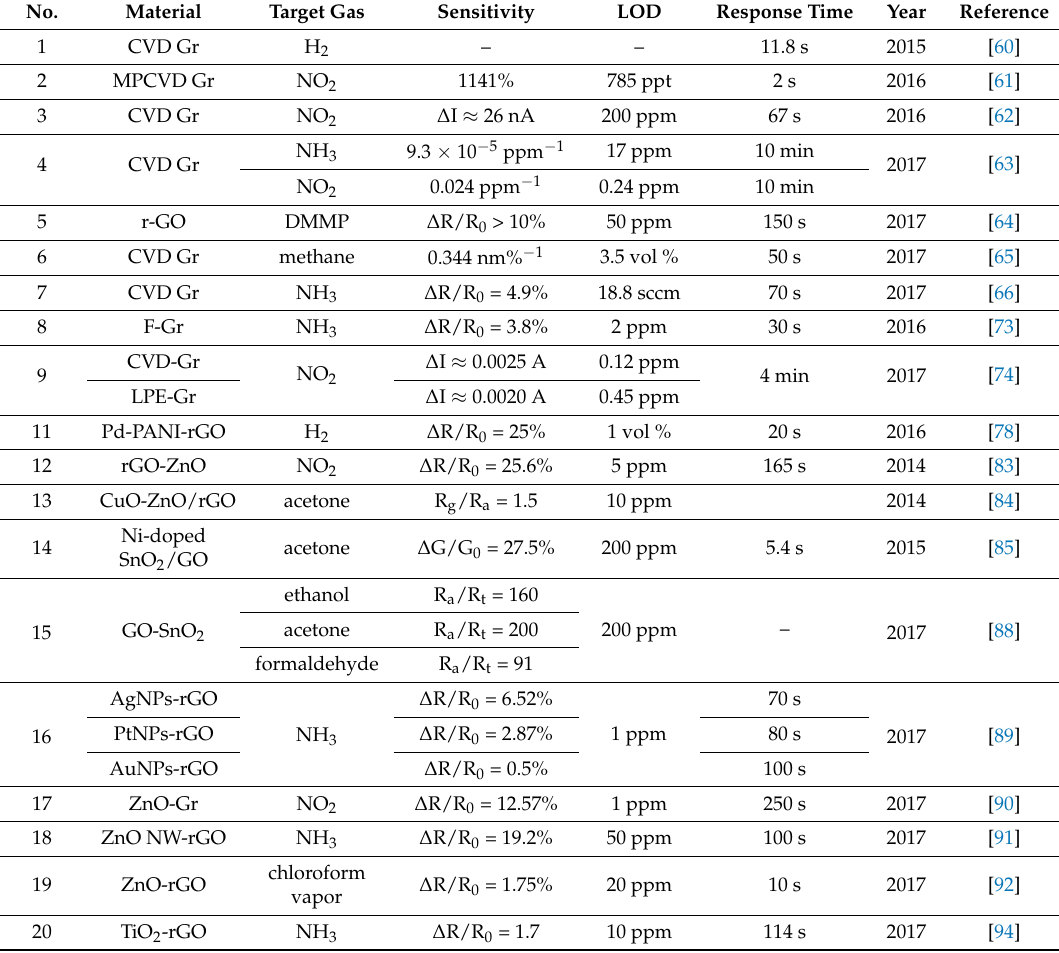
Table 3. Typical gas sensors based on graphene